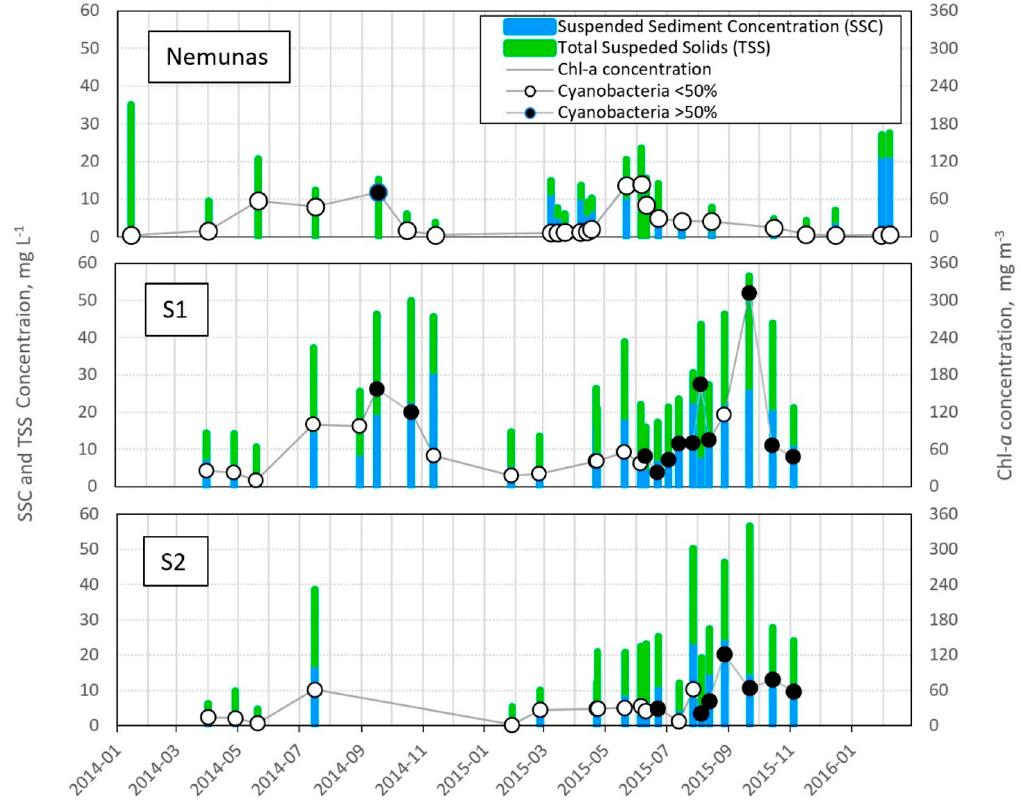
Figure 4. The time series of total (TSS), mineral sediment (SSC), and Chl- a concentrations and percentage of the cyanobacteria from the total phytoplankton community for monitoring stations Nemunas, S1, and S2. Columns without SSC values indicate field campaigns where only TSS were